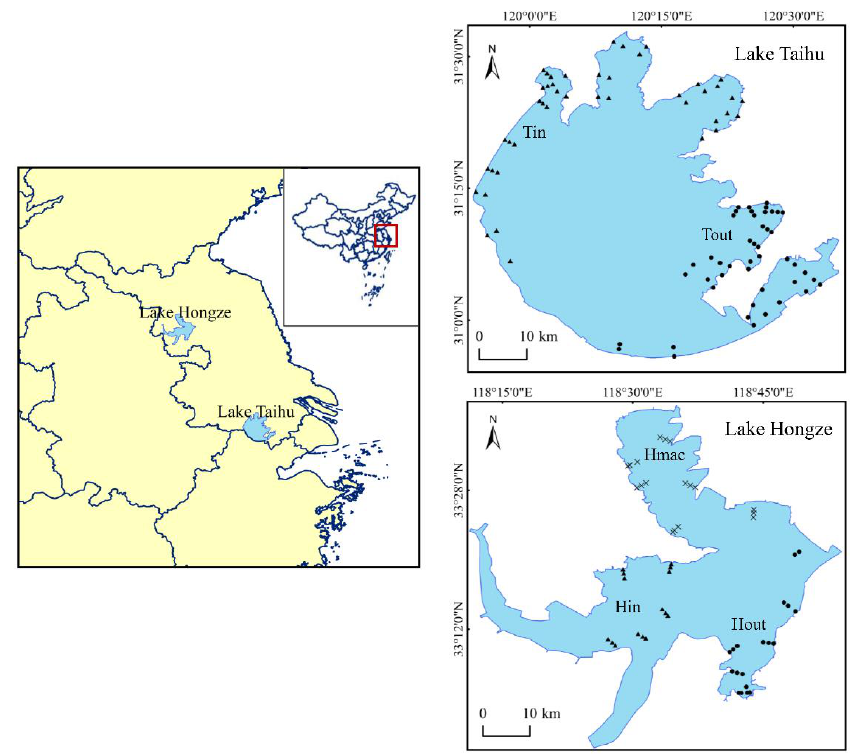
Figure 1. Locations of the sampling sites and different sections in littoral zones of Lakes Taihu and Hongze in August 2017. The inflowing-river-affected zones (filled triangles, Tin and Hin), the outflowing-river-connected zones (filled circles, Tout and Hout), and lightly-affected by rivers and aquatic macrophyte-dominated zone (furcation, Hmac).